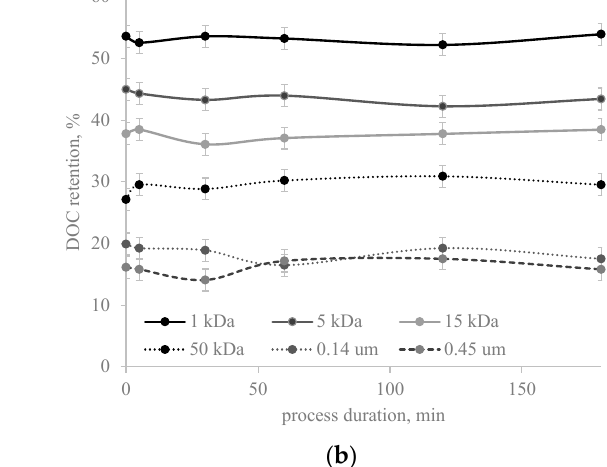
Figure 5. Influence of membrane filtration time on the reduction efficacy of COD ( a ) and DOC ( b ) during digestate liquid fraction treatment (TMP 0.2 MPa).